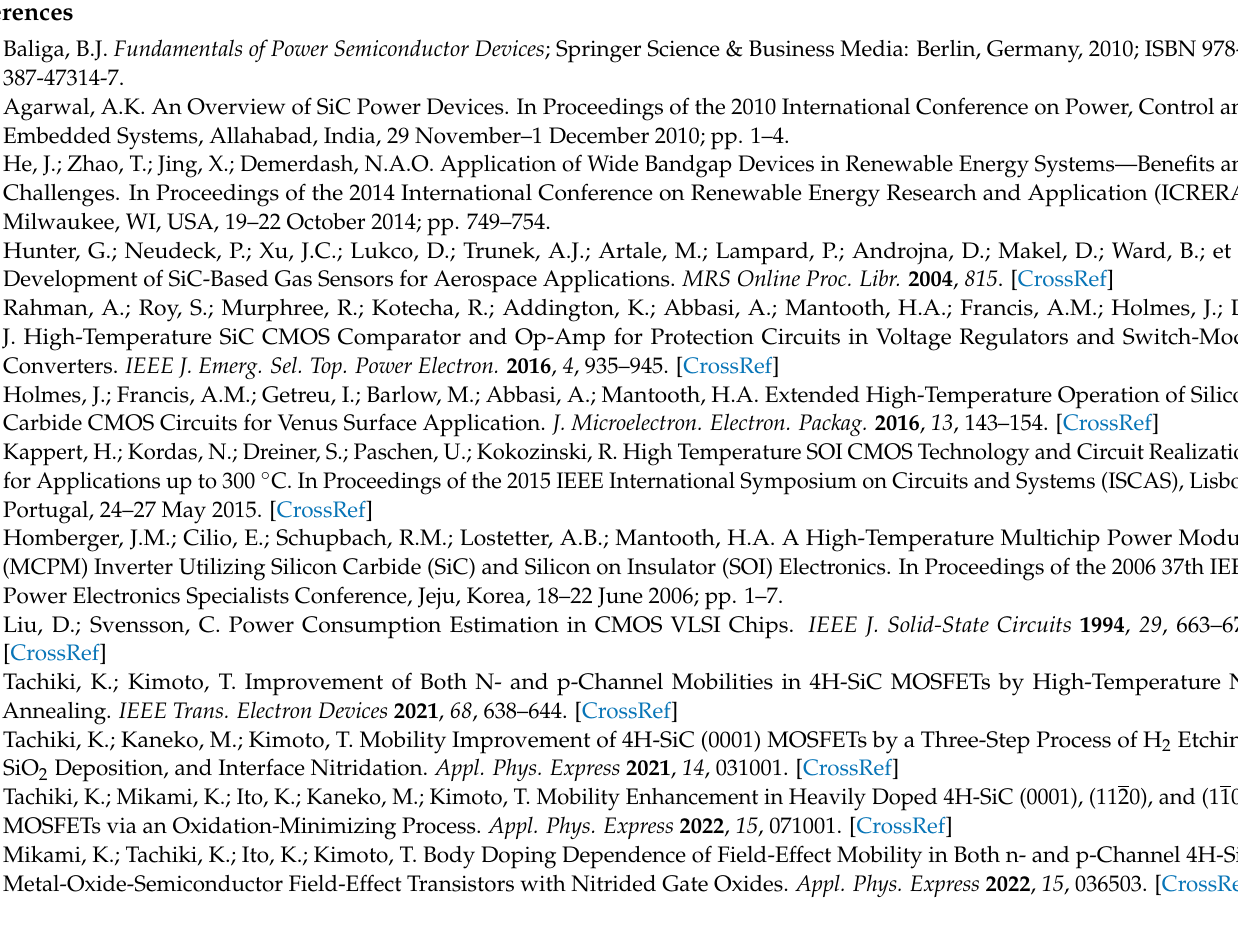
Figure S2: Surface roughness scattering at a high hole concentration. Figure S3: Hole mobility versus transverse electric field for different body biases at room